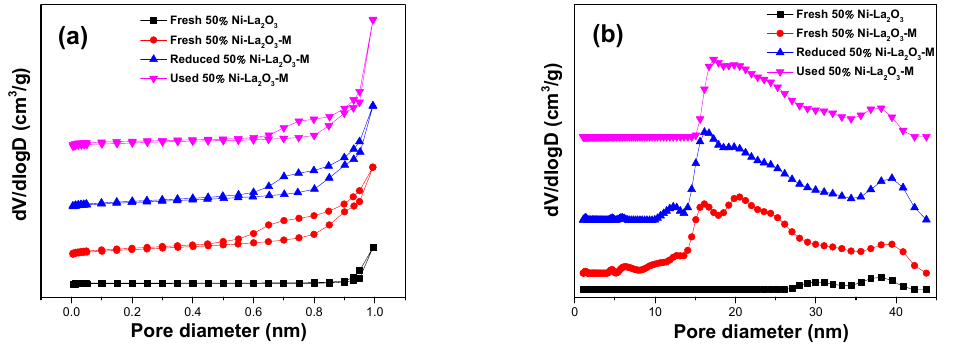
Figure 1. Nitrogen adsorption–desorption isotherms curves ( a ) and pore size distributions ( b ) of 50% Ni–La 2 O 3 –M and 50% Ni–La 2 O 3 .